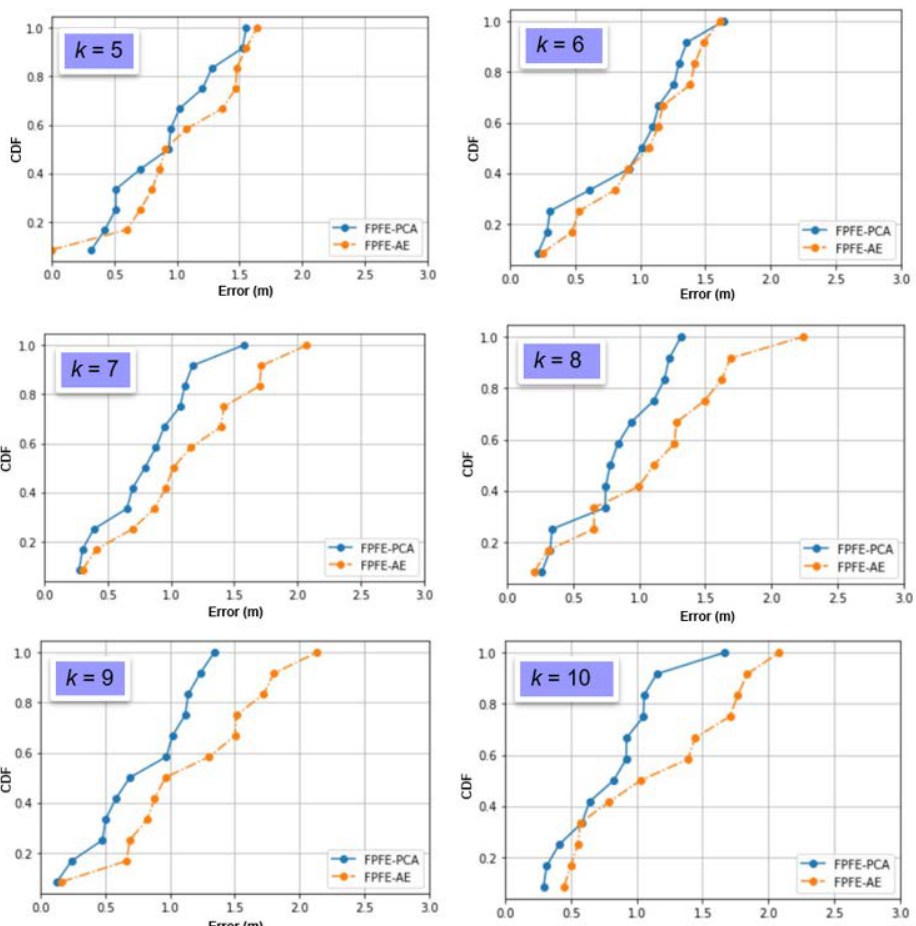
Figure 13. The localization error box and whisker plots of FPFE with 93 random RPs for k RP candi- dates, where k = 5, 6, 7, 8, 9, and 10.